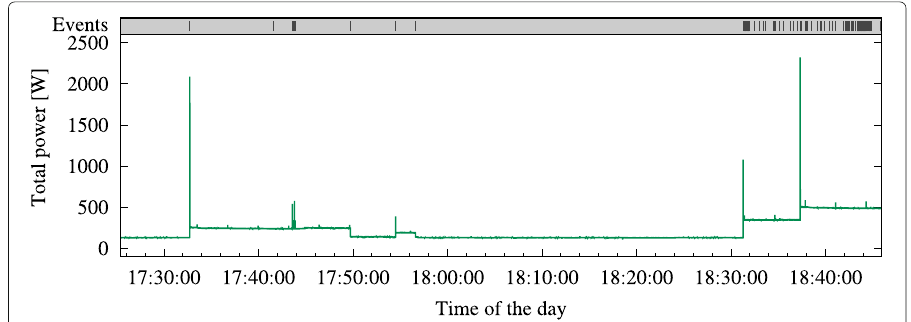
Fig. 5 Events detected by the threshold aon input data reduced by a factor of